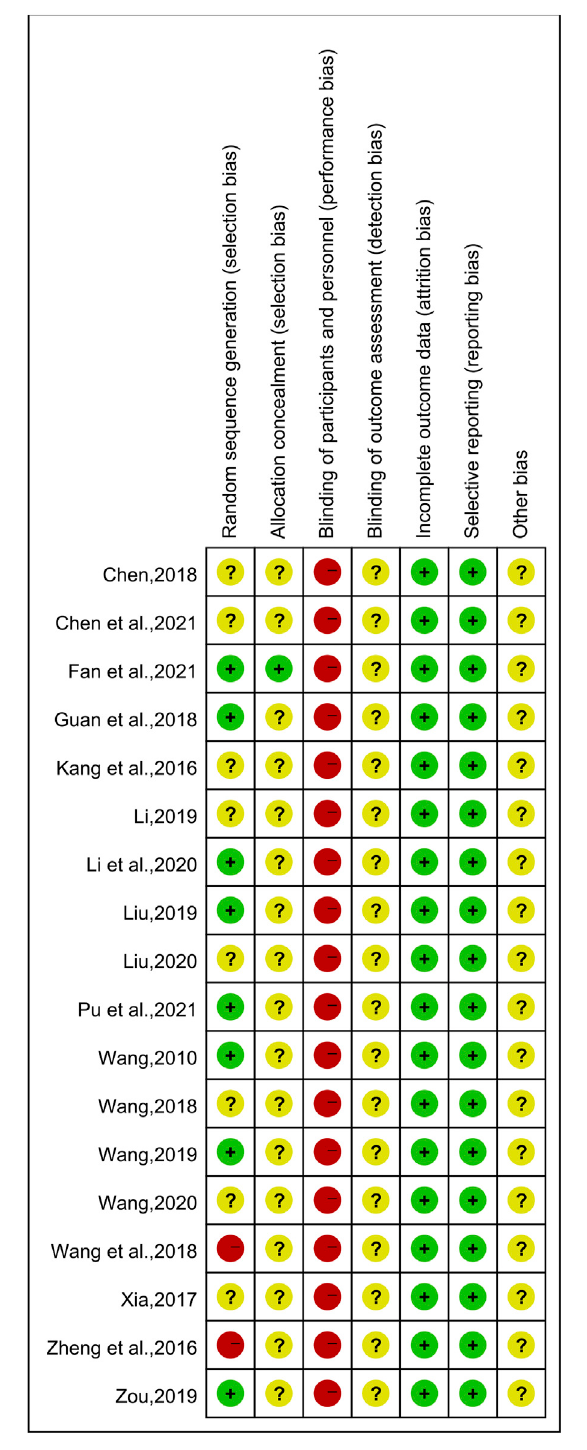
FIGURE 3 | Risk of bias